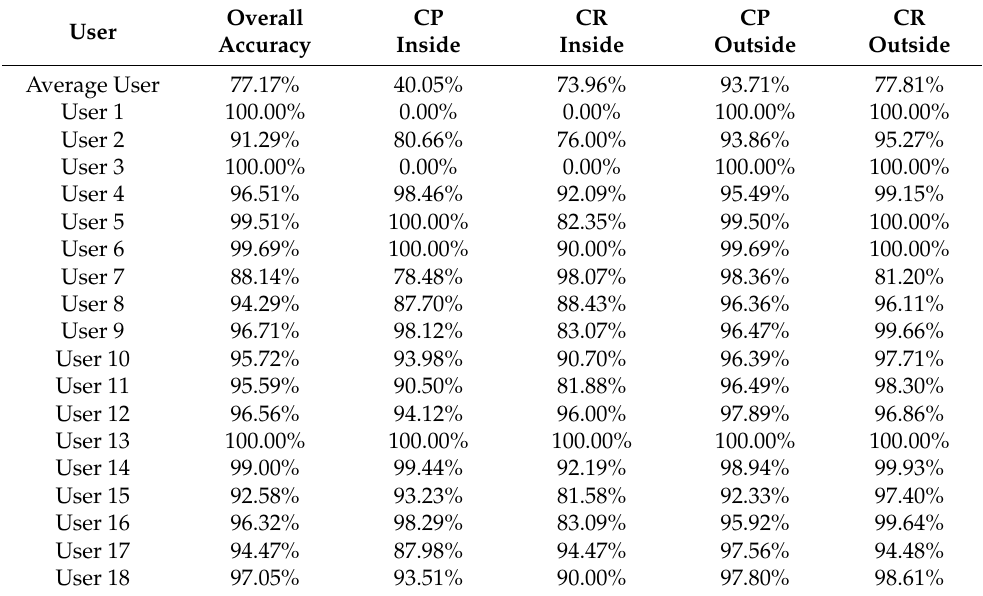
Table 4. Summary of results for performing indoor localization to detect whether a specific user is located inside or outside a specific indoor spatial region out of the 254 indoor spatial